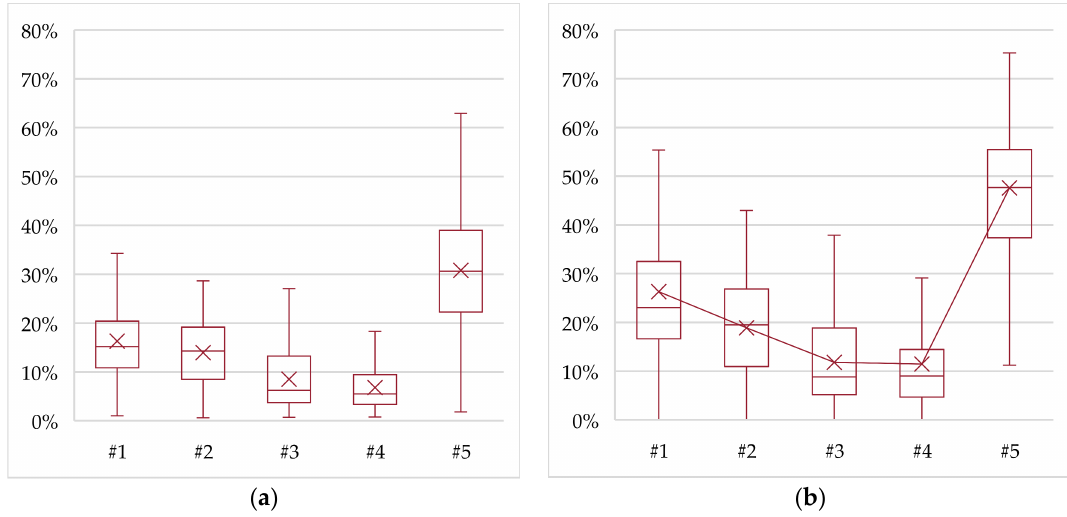
Figure 6. Resulted savings of ( a ) primary energy consumption; ( b ) local emissions.